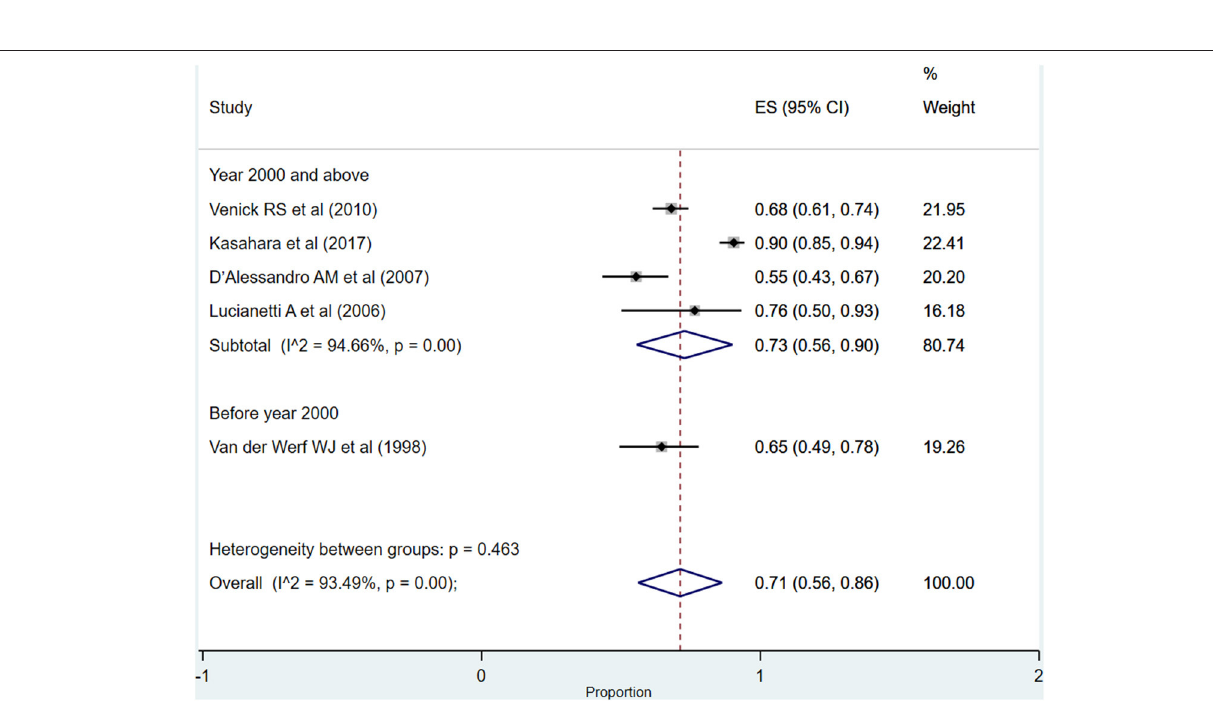
Frontiers in Pediatrics |